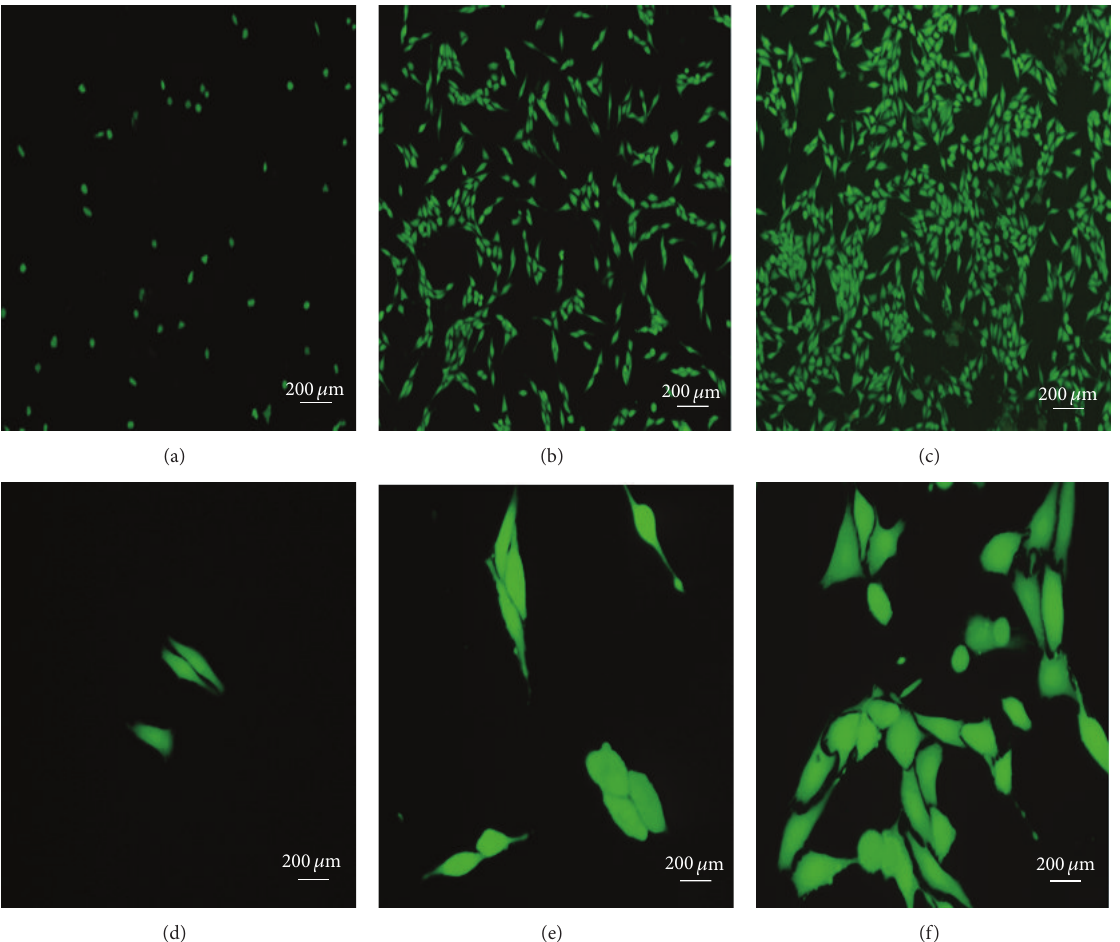
Figure 9: Viability assays of MG63 cells after different days cultured on PVDF scaffolds: ((a) low and (d) high magnified image) 1 day; ((b) low and (e) high magnified image) 3 days; ((c) low and (f) high magnified image) 5